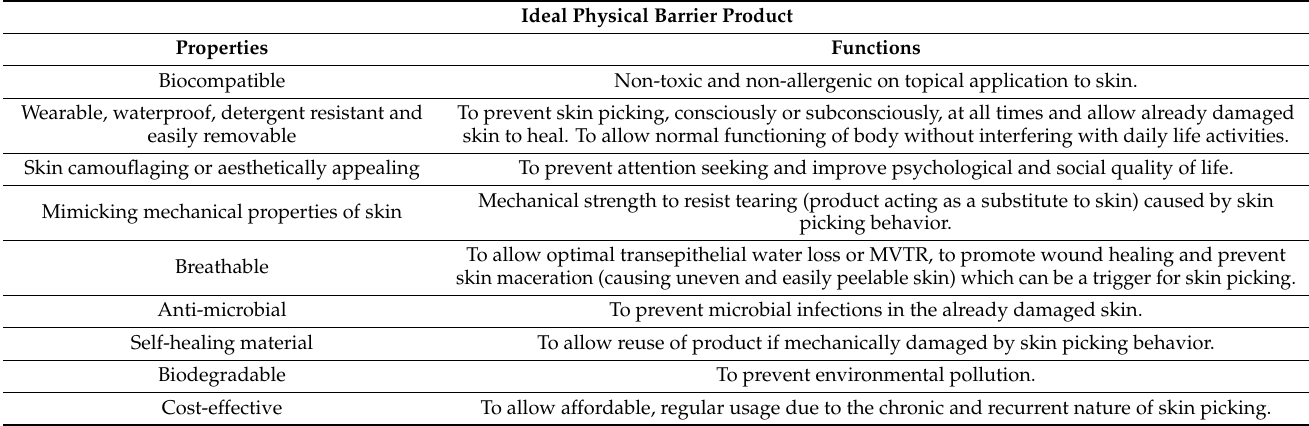
Table 2. Required properties and functions for an ideal physical barrier